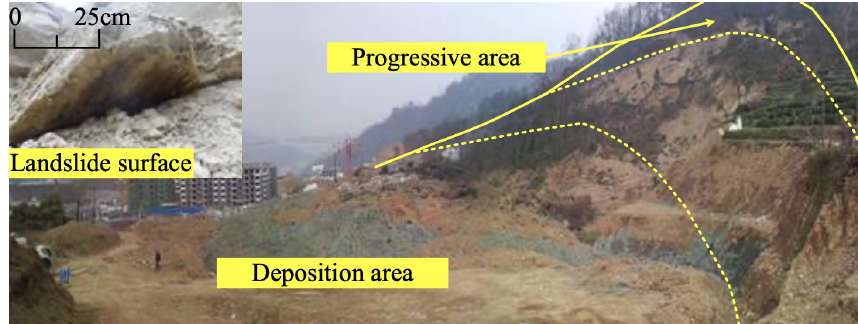
Figure 3. Landslide YYG03 caused by slope incision in a residential quarter of